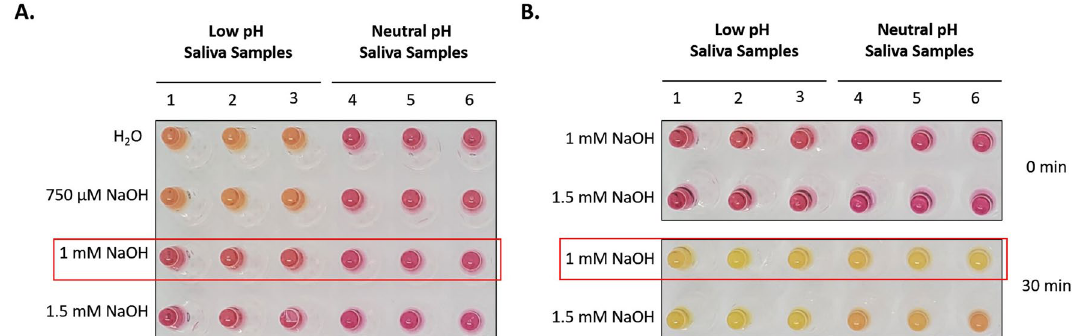
Figure 1. Neutralization of Acidic Saliva Using NaOH Solution. ( A ) Acidic (low pH) and normal (neutral pH) saliva samples were diluted with different concentrations of NaOH solution. The picture was taken immediately after the dilution. The test was performed with 3 independent samples for each group. ( B ) Acidic and normal saliva samples were spiked with 20 copies/µl of synthetic SARS-CoV-2 RNA and then diluted in different concentrations of NaOH solution. The spiked samples were then processed with SaliVISION test at 65 °C for 30 min. The final copy number of synthetic viral RNA was 50 copies per reaction. The red box indicates the